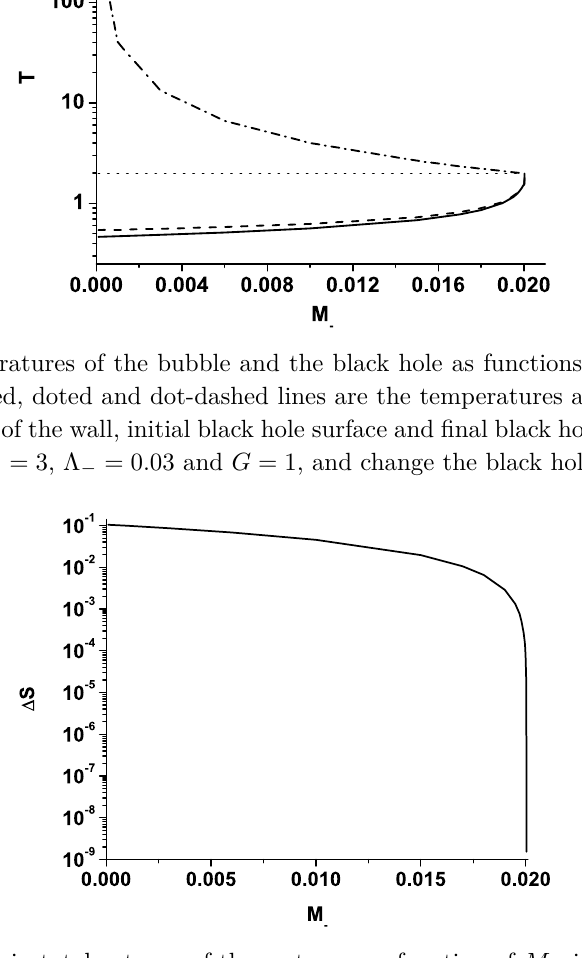
Figure 7 . The change in total entropy of the system as a function of M − in de Sitter space. The entropy is always increasing. As long as M − / M + , ∆ S reduces with M − slowly. The reduction becomes very quick when M − / M + . This implies that the black hole prefers to reduce its energy while triggering the vacuum decay. We set M + = 0 . 02 , Λ + = 3 , Λ − = 0 . 03 and G = 1 , and change the black hole rest mass M −